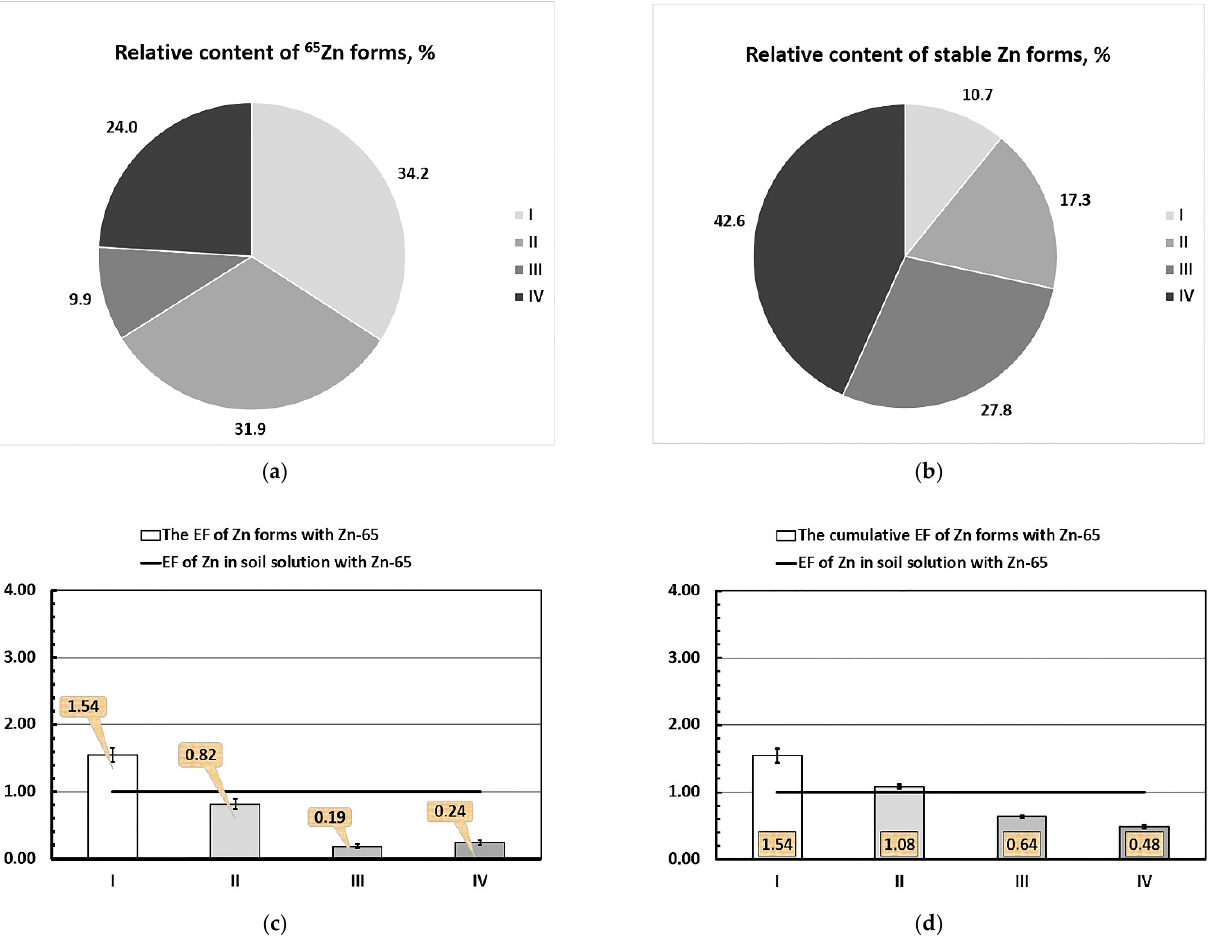
Figure 11. The relative content (%) of the forms of stable (natural) Zn ( a ) and 65 Zn ( b ) in Albic Retisol (Loamic, Ochric) soil, as determined by the modified BCR method [21]; the enrichment factors ( EF ) of Zn forms by 65 Zn in the soil ( c ); the cumulative EF of Zn forms by 65 Zn in the soil ( d ). Roman numerals I–IV indicate the forms of zinc in the soil, as given in Table 2.